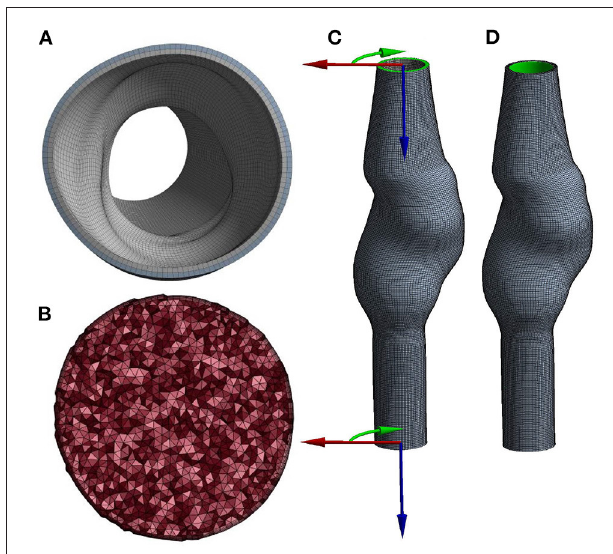
FIGURE 2 | Cross-section of the (A) solid and (B) fluid volume mesh, and a visualization of (C) the boundary conditions at the inlet and outlet, using cylindrical coordinate systems and (D) the area (highlighted in green) to which pressure is